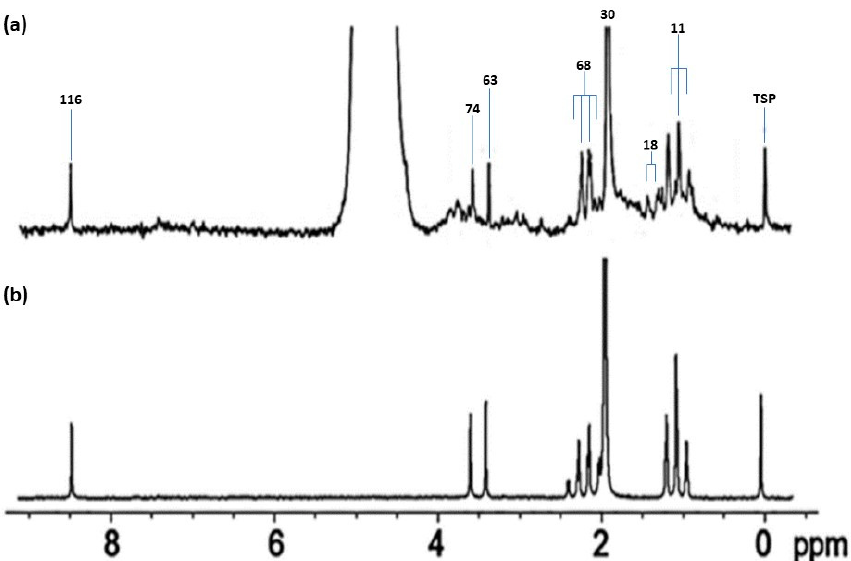
Figure 13. ( a , b ) Experimental and predictively simulated 60 MHz 1 H NMR profiles of a healthy human WMS supernatant sample; the predicted spectrum in ( b ) was computed from metabolite concentrations determined at an operating frequency of 400 MHz. Concentrations of salivary biomolecules featured were propionate (-CH 3 resonance 11, 3.25 mmol./L); acetate (-CH 3 resonance 30, 19.33 mmol./L); methanol (-CH 3 resonance 63, 350 µ mol./L); glycine (-CH 2 resonance 74, 750 µ mol./L); and formate (-CH resonance 116, 560 µ mol./L). The lactate-CH 3 signal was excluded from this simulation in view of complications arising from overlap with other resonances (typical spectra are shown). Resonance labels correspond to those provided in Table 1 (TSP represents the 3-(trimethylsilyl)propionate-2,2,3,3-d4 chemical shift reference and quantitative internal standard). At this low operating frequency, further spin–spin splitting of propionate’s -CH 3 and -CH 2